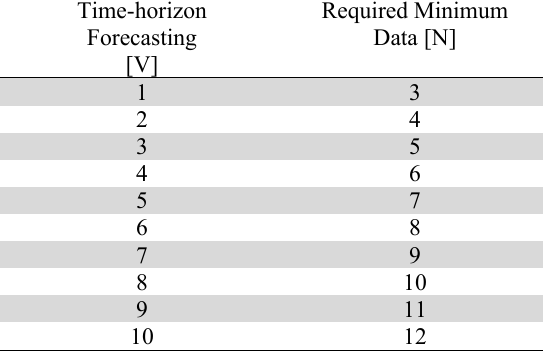
Minimum Data Test Required to Forecast